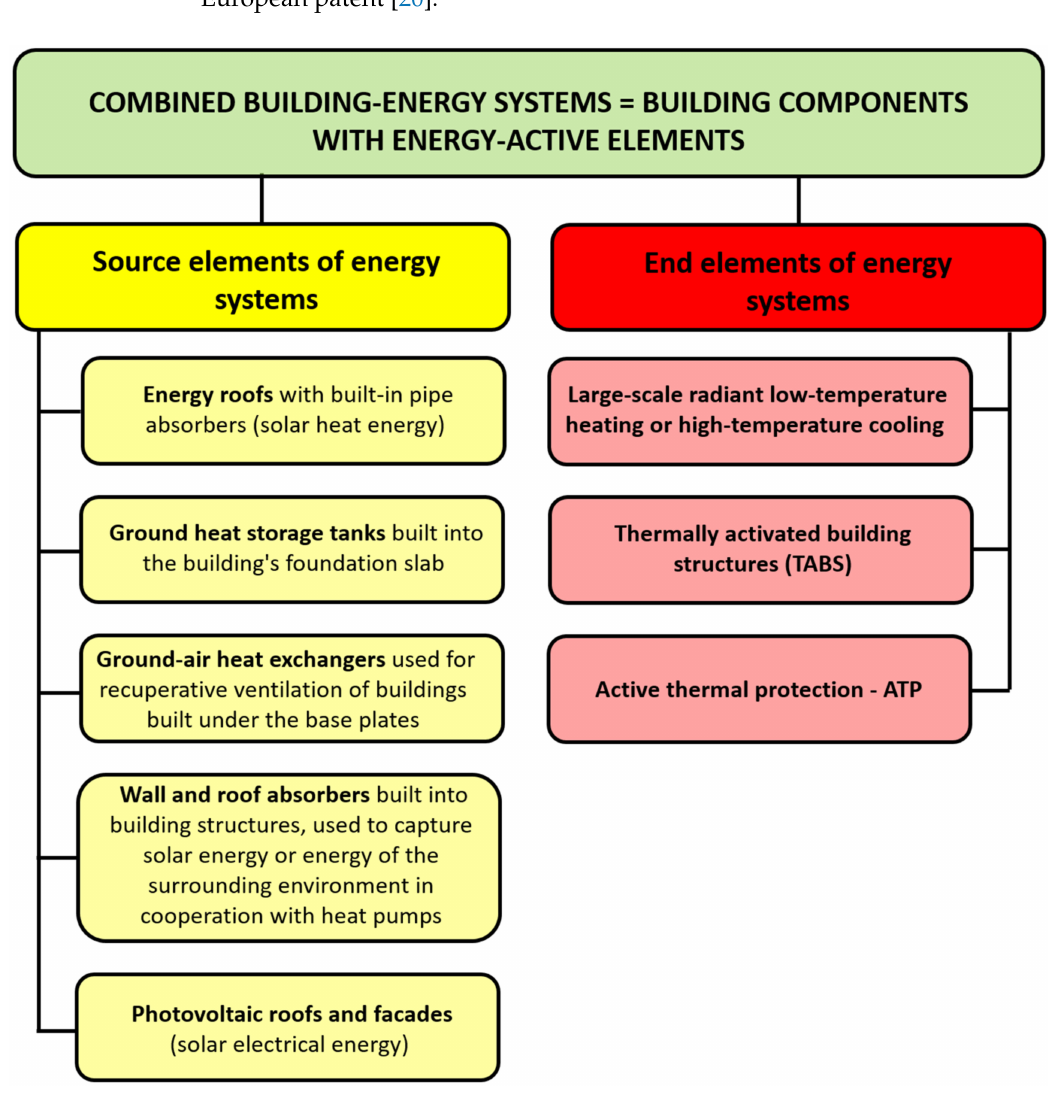
Figure 1. Overview of source elements of energy systems and end elements of energy systems of combined building-energy